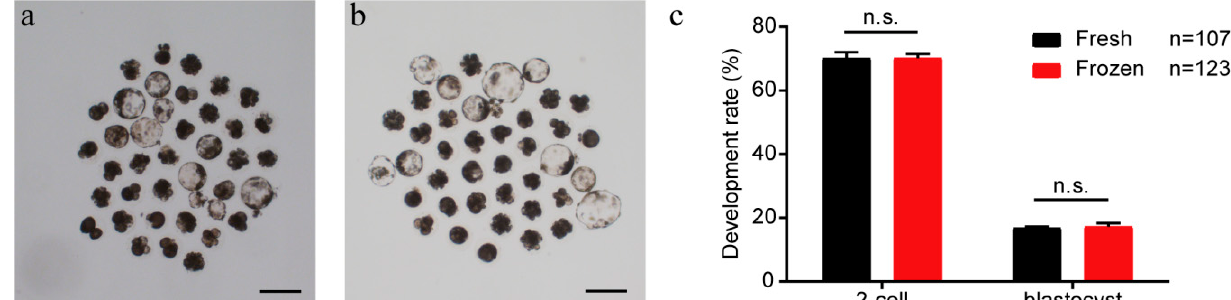
Figure 8. Effects of ear tissue vitrification on the development of SCNT embryos. ( a , b ) Representative images of SCNT blastocysts constructed by using cells isolated from fresh ( a ) and thawed ( b ) tissues. Scale bar = 200 µm; ( c ) Percentages of cleavage and blastocyst for SCNT embryos. Error bars represent the SEM.